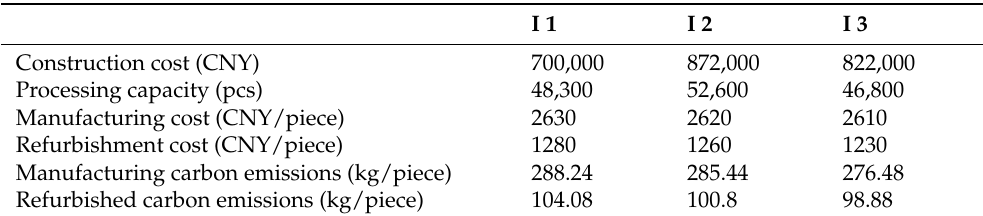
Table A8. Details of various costs, processing capacity and unit carbon emissions of manufacturing